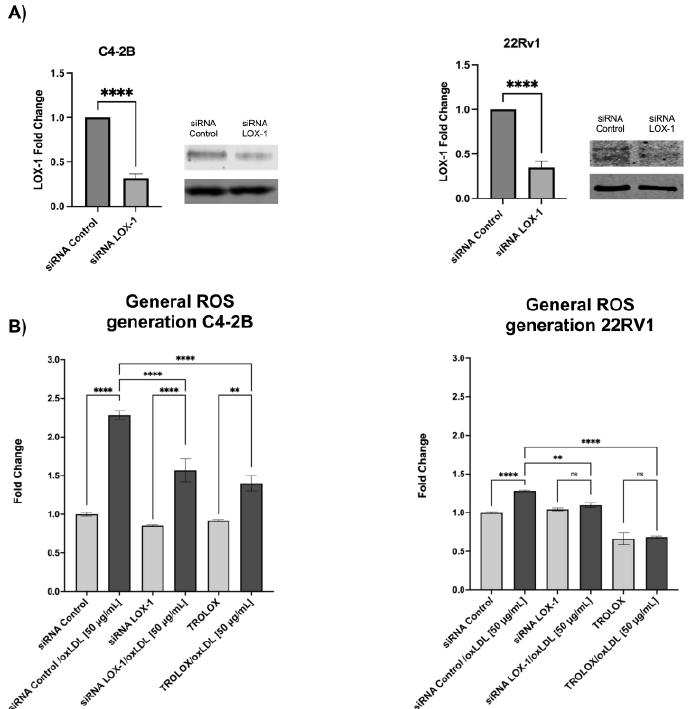
Figure 1. ( A ) Western blot of LOX-1 expression in CRPC cells, C4-2B and 22RV1 transfected with siRNA against LOX-1. To silence the LOX-1 RNA expression, C4-2B and 22RV1 prostate cancer cell lines were transfected with siRNA-LOX-1 or siRNA-control for 48 h, and the expression of LOX-1 was analyzed by Western blot. ( B ) OxLDL/LOX-1 induces ROS generation in castration-resistant prostate cancer cell models . C4-2B and 22Rv1 were transfected with a siRNA against LOX-1 or the control for 48 h or treated with 25 μ M Trolox and then treated with 50 μ g/mL oxLDL, and the ROS generation was analyzed 3 h post-treatment. The data represent the means ± S.D. of three independent experiments analyzed by one-way analysis of variance and Dunnett ’ s post-test or t -test for LOX-1 expression analysis (**** p ≤ 0.0001, ** p ≤ 0.01 , ns: non-significant statistical difference).